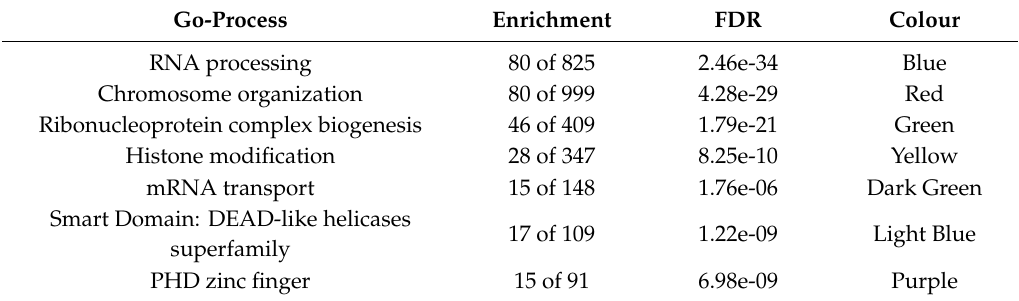
The connecting lines (edges) are coloured as indicated